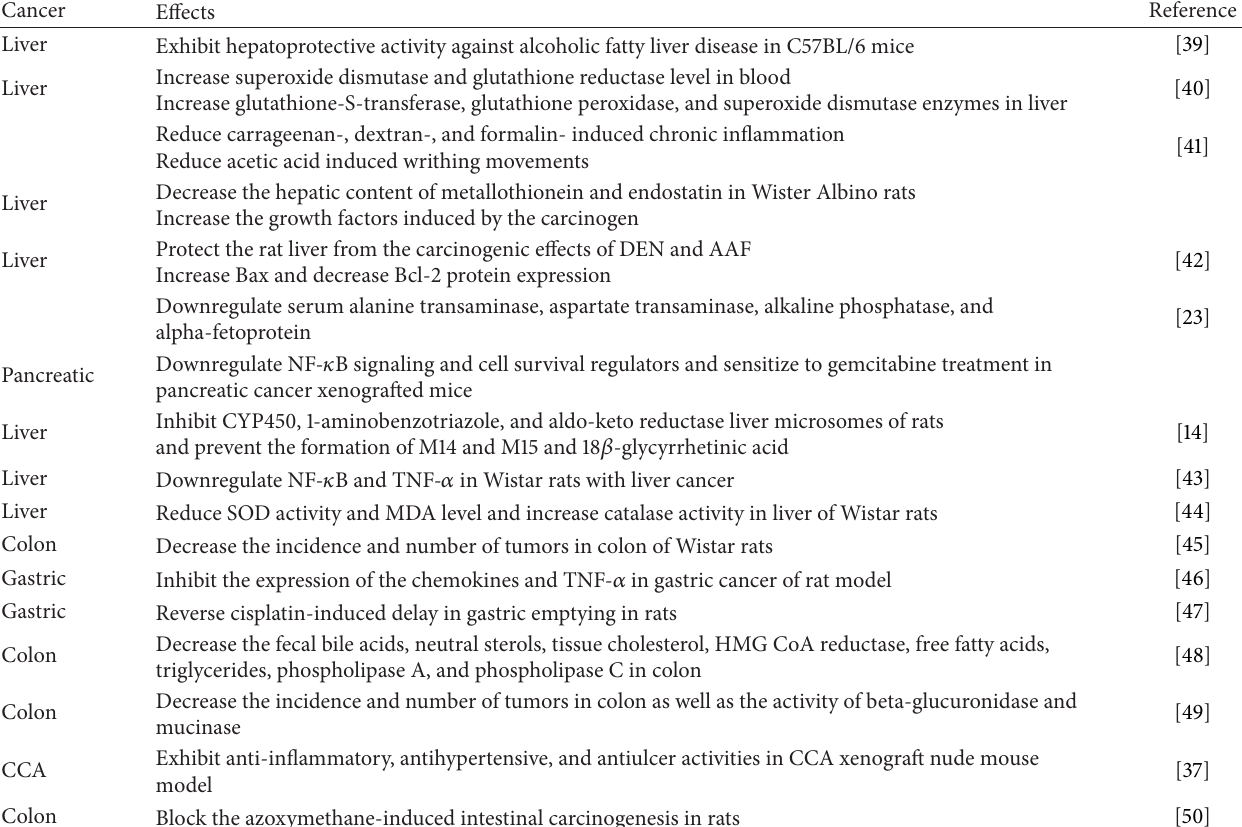
Table 2: In vivo effects of ginger and its constituents against various GI cancer models.